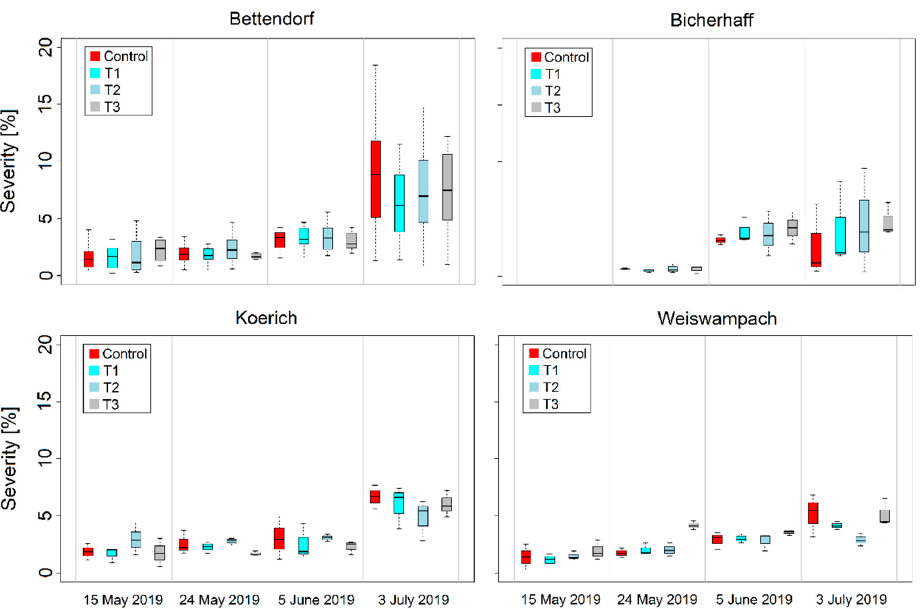
Figure 4. Variations of the Red-Green-Blue (RGB) imagery-based estimates of wheat stripe rust (WSR) during the monitoring period in 2019 at the experimental sites in the Grand-Duchy of Luxembourg. T1, T2, and T3 refer to single, double, and triple fungicide-treated plots (Table 1); Control refers to the non-fungicide treated plots. The horizontal line represents the median value, surrounded by box edges presenting the 25th and 75th percentiles. The whiskers are the two lines outside of the box that extend to the highest and lowest data values. No data is available at Bicherhaff on 15 May 2019 since the images were blurry due to high velocity wind during the unmanned aerial vehicle flight.